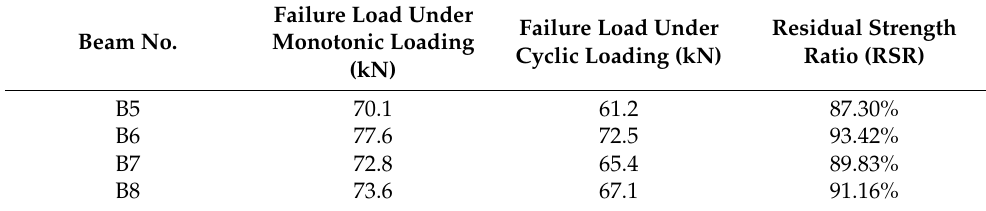
Table 5. Failure loads of all tested beams.